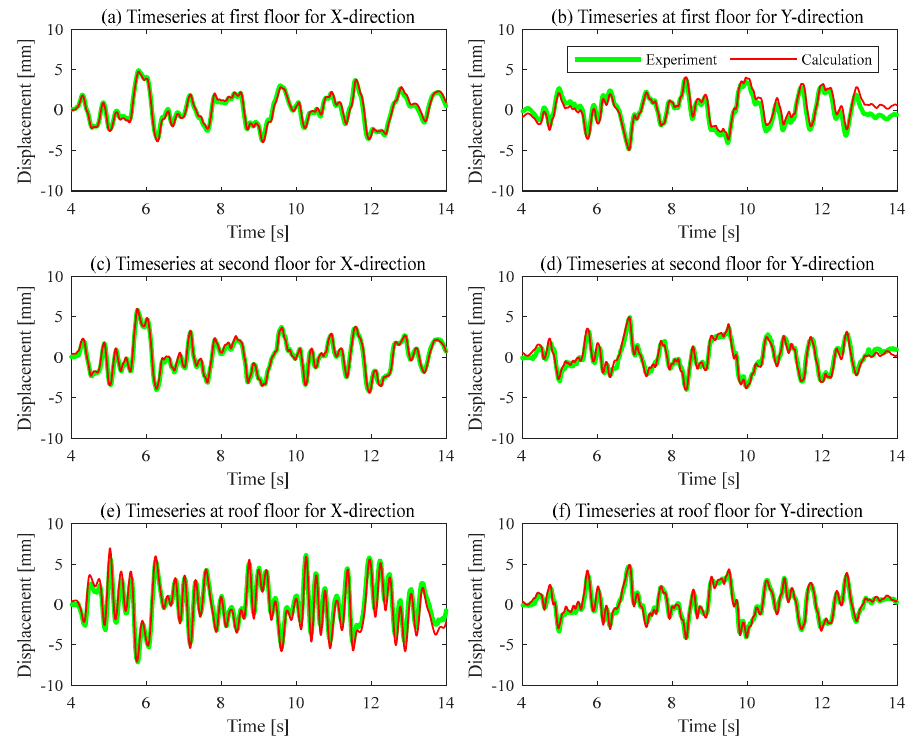
Figure 7. Comparison of displacements calculated by acceleration measured from reference accelerometers and smartphones along the X and Y directions in test 3.